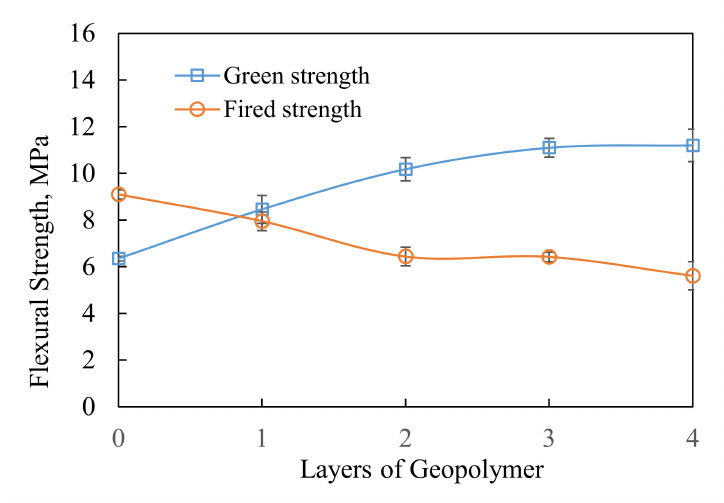
Figure 8. Flexural strength of shell mould at room temperature and after sintering at 1125 ◦